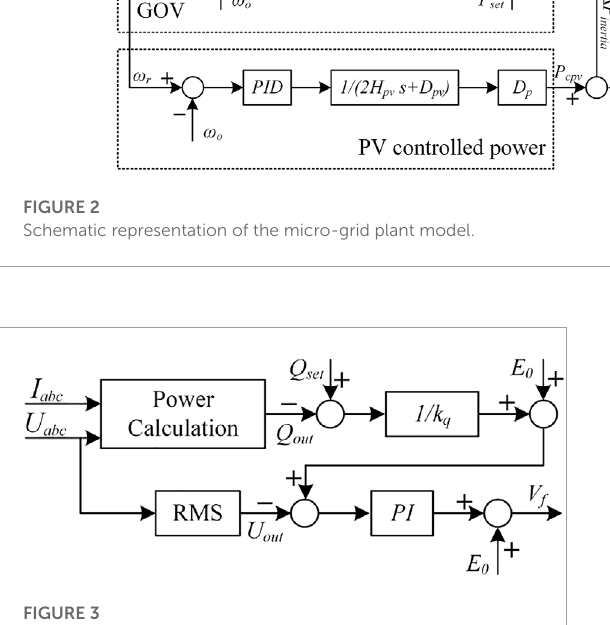
FIGURE 5 Power reserve and the VIC strategy of the PV.